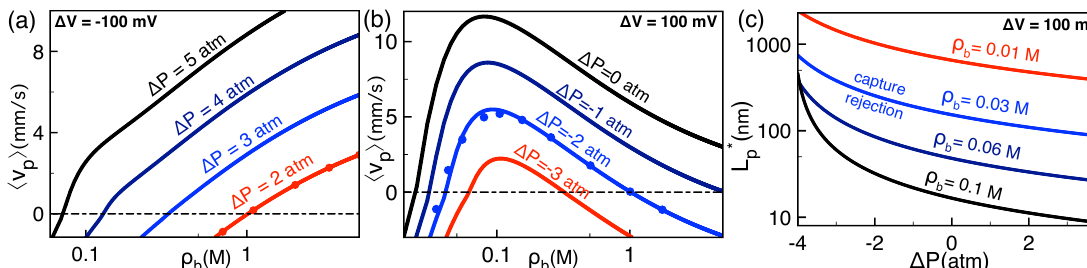
Figure 3. Average polymer velocity from Equation (28) (solid curves) and the drift formula (31) (dots) versus salt concentration in ( a ) voltage-limited ( ∆ V = − 100 mV) and ( b ) voltage-driven translocation ( ∆ V = 100 mV). ( c ) Characteristic polymer length in Equation (40) separating the polymer capture and rejection regimes versus the pressure ∆ P in voltage-driven translocation with ∆ V = 100 mV. The remaining parameters are the same as in Figure 2. The results are from Ref.